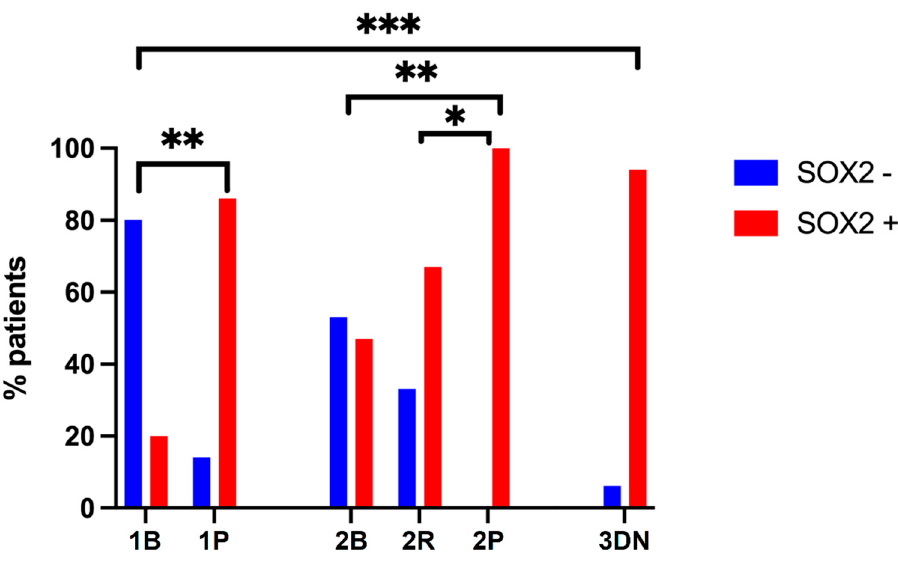
Figure 3. SOX2 IHC expression at first diagnosis in meningioma belonging to different groups. *p <0.05; ** p <0.01; *** p <0.0001.